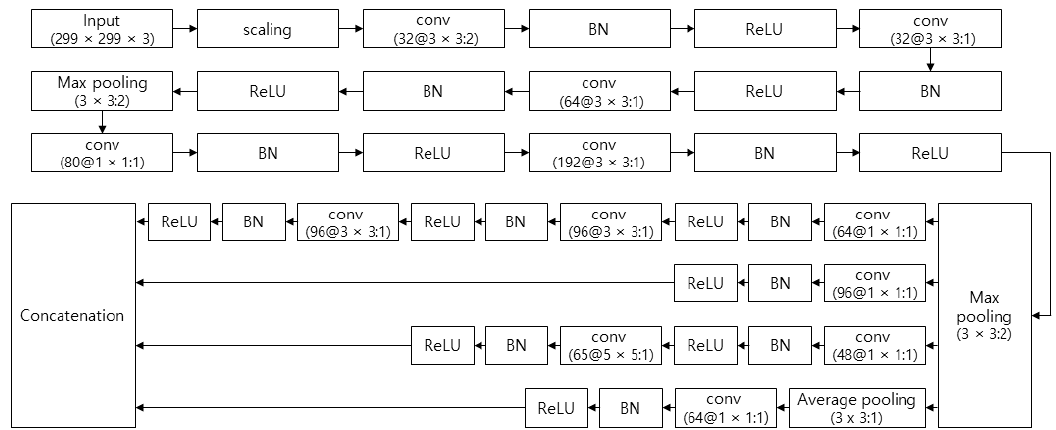
Figure 5. Stem layer of InceptionResNetV2. BN, batch normalization; ReLU, rectified linear unit.